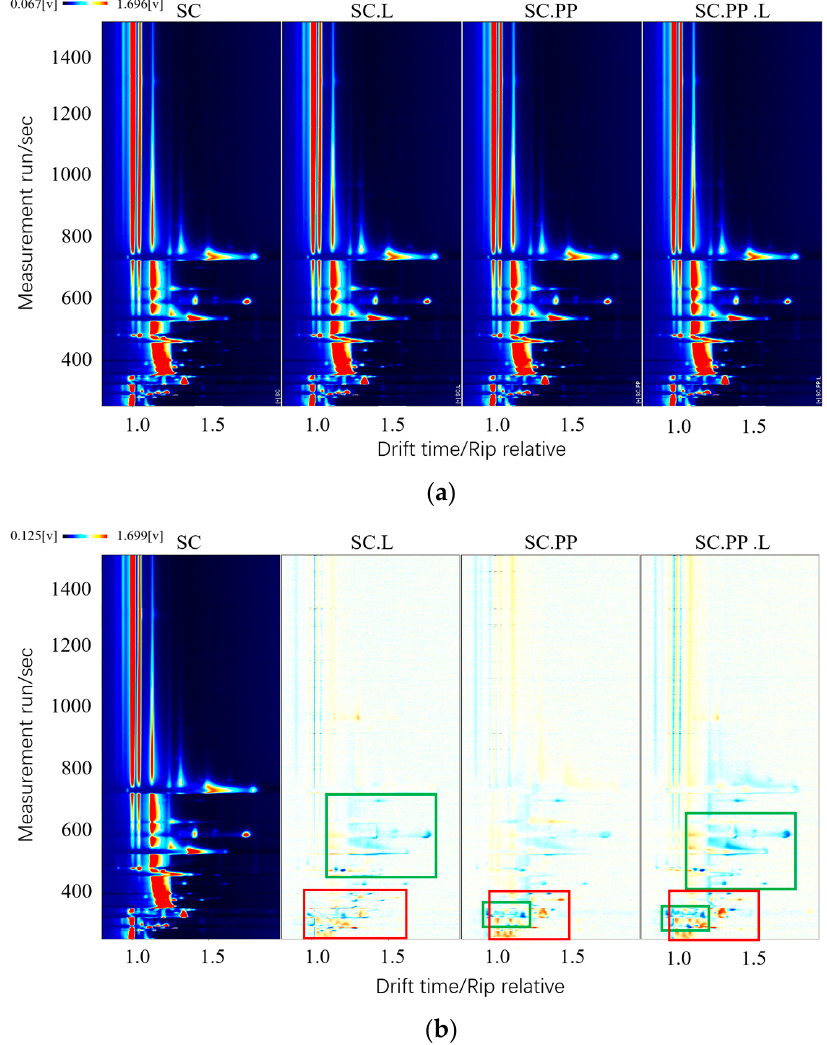
Figure 2. GC-IMS Two-Dimensional Spectra. ( a ) Intuitive comparison Spectra; ( b ) difference compar- ison Spectra. ( S. cerevisiae -‘SC’, S. cerevisiae and Lactobacillus -‘SC.L’, S. cerevisiae , and P. pastoris